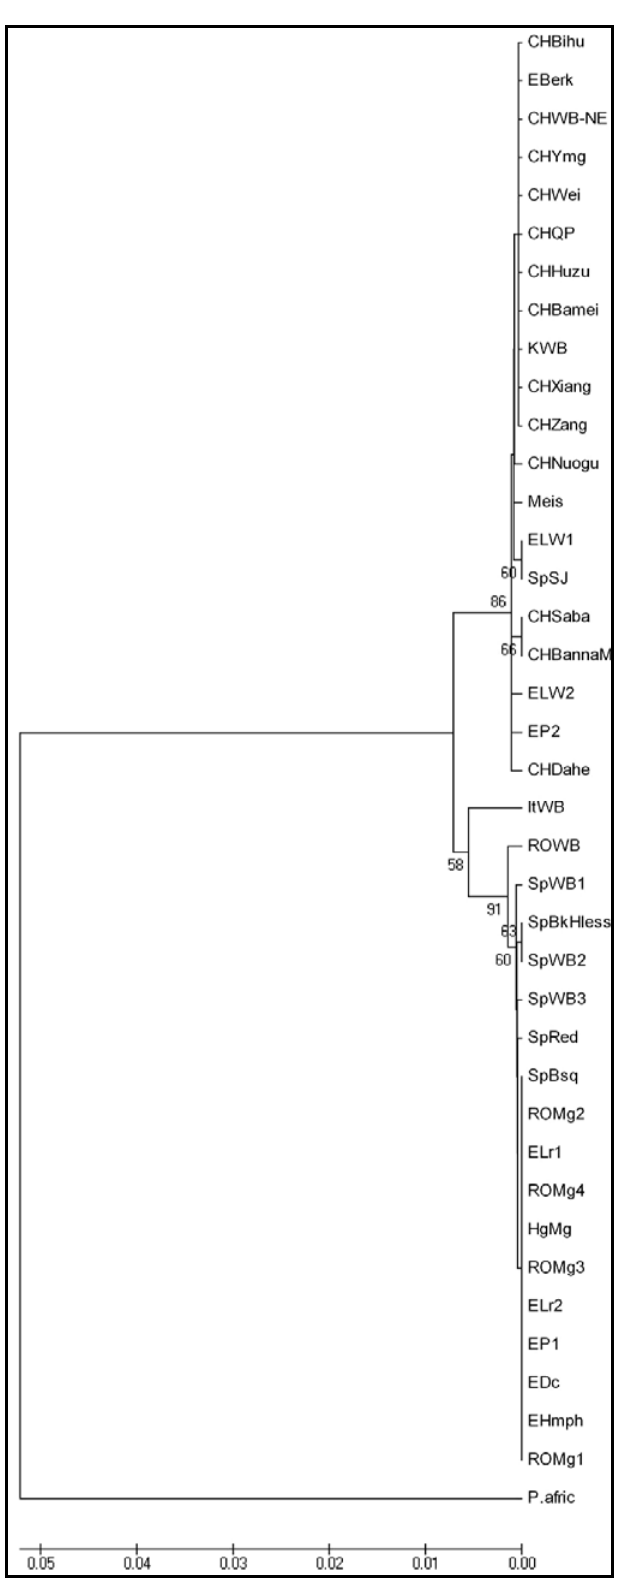
Figure 2. Neighbor-Joining tree based on cytochrome b sequence of 32 different haplotypes, including 24 swine breeds and 5 Wild Boar populations. Figures on the internodes are bootstrap probabilities based on 1000 replications. Outgroup: Phacochoerus africanus